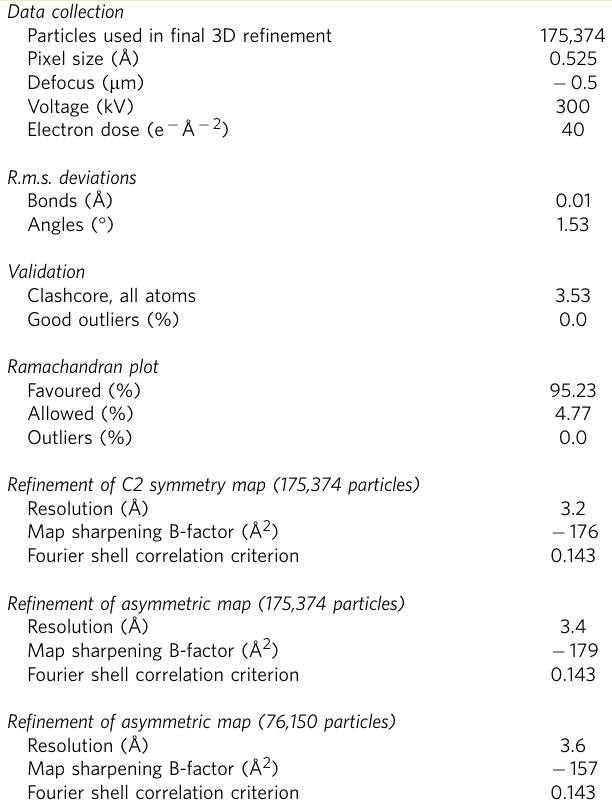
Table 1 | Data collection, refinement parameters and model statistics. Data collection Particles used in final 3D